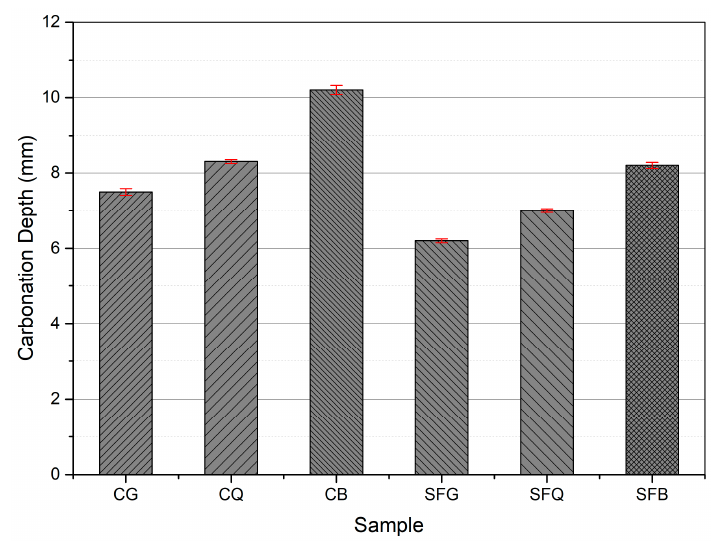
Figure 5. Carbonation depths for concrete specimens.